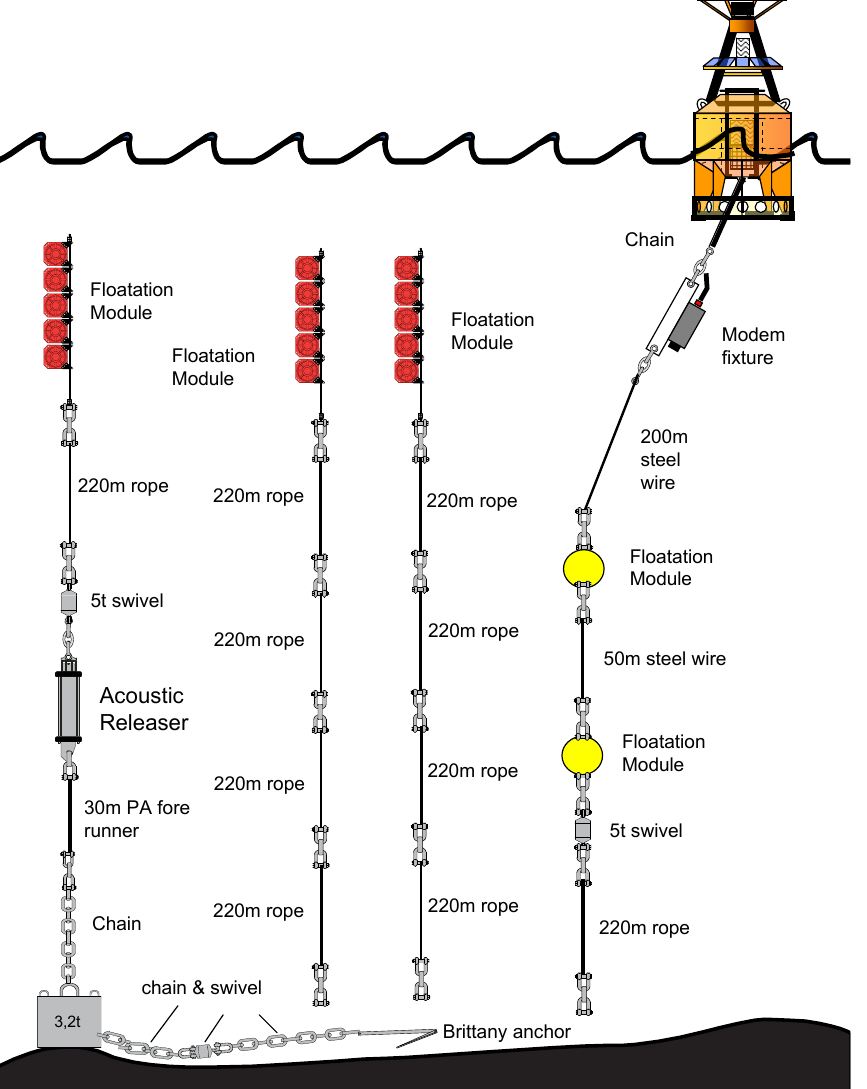
Fig. 3. Typical mooring configuration for 2500m water depth for a buoy hosting an acoustic modem. All equipment (except the buoy) is rated and tested for water pressure of up to a 6000m water column. The mooring was designed by Nautilus GmbH, Bremen